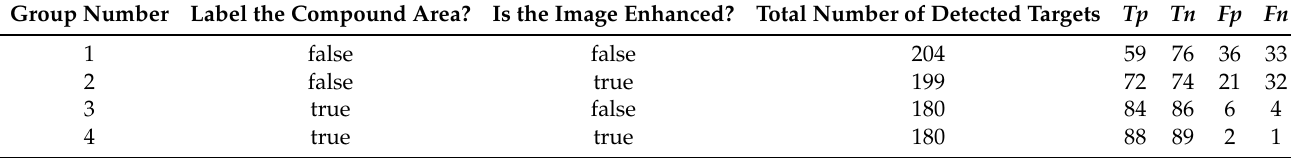
Table 1. Summary of test results of different